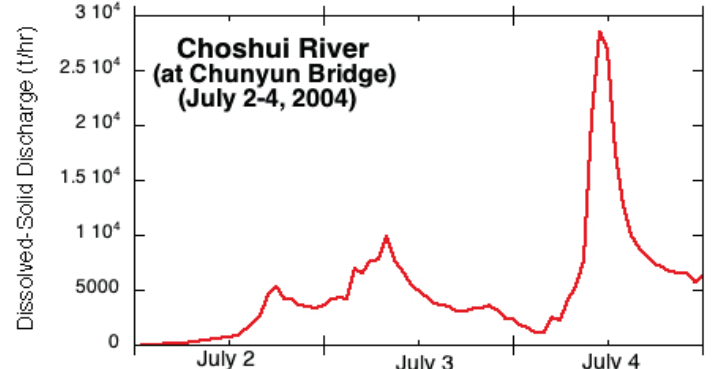
Fig. 10 Calculated dissolved-solid discharge past the Chunyun Bridge, 2–4 July 2004.